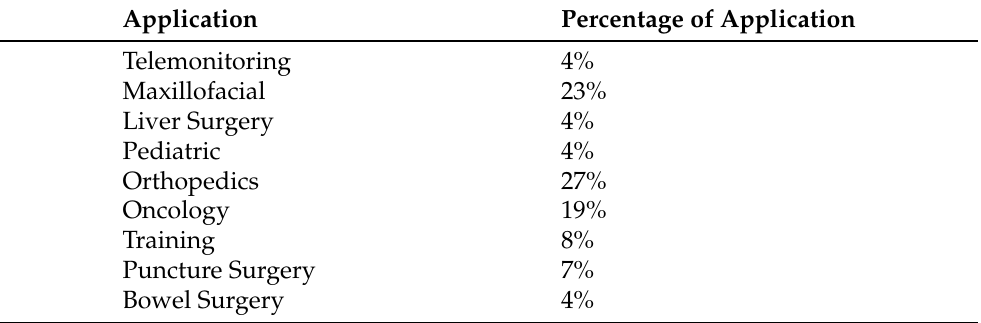
Table 2. Augmented Reality Applications.